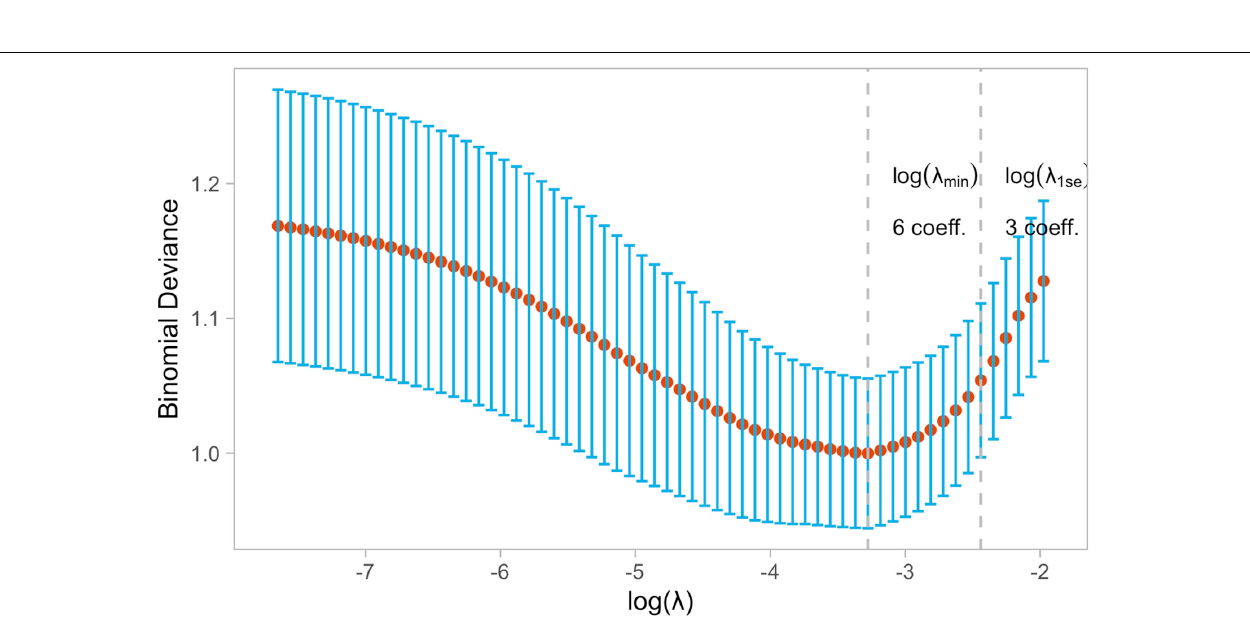
FIGURE 3 | The Least Absolute Shrinkage and Selection Operator (LASSO) binary logistic regression model was used to select clinical features. The binomial deviance metrics (the y-axis) were plotted against log( λ ) (the bottom x-axis) and the LASSO model used fivefold cross-validation via minimum criteria.